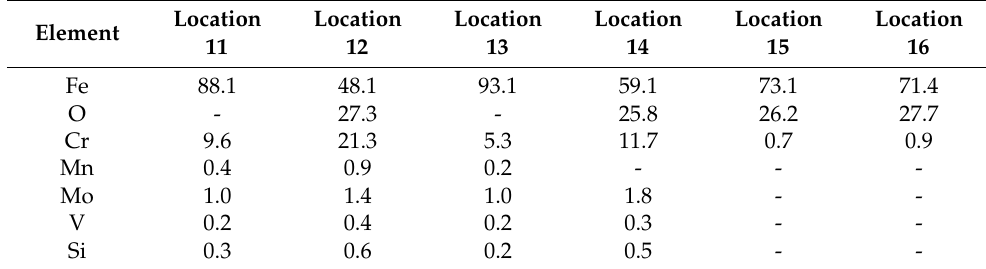
Table 5. Quantitative EDX analysis, P91 steel oxidized at 650 ◦ C for 2000 h (in wt.%). Element